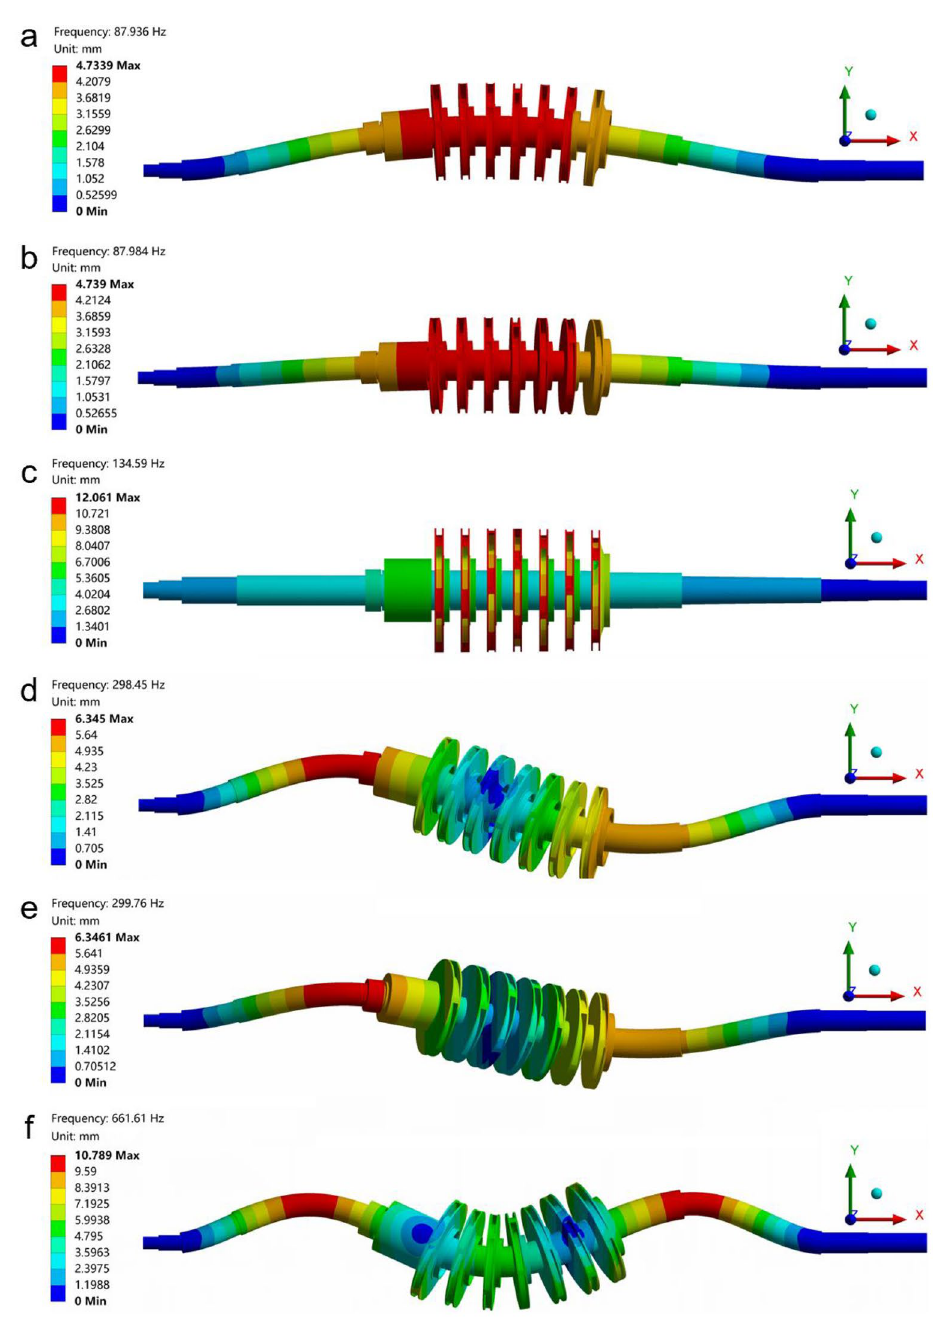
Figure 5. The first six mode shapes of the centrifugal pump rotor system. ( a ) First mode shape. ( b ) Second mode shape. ( c ) Third mode shape. ( d ) Fourth mode shape. ( e ) Fifth mode shape. ( f ) Sixth mode